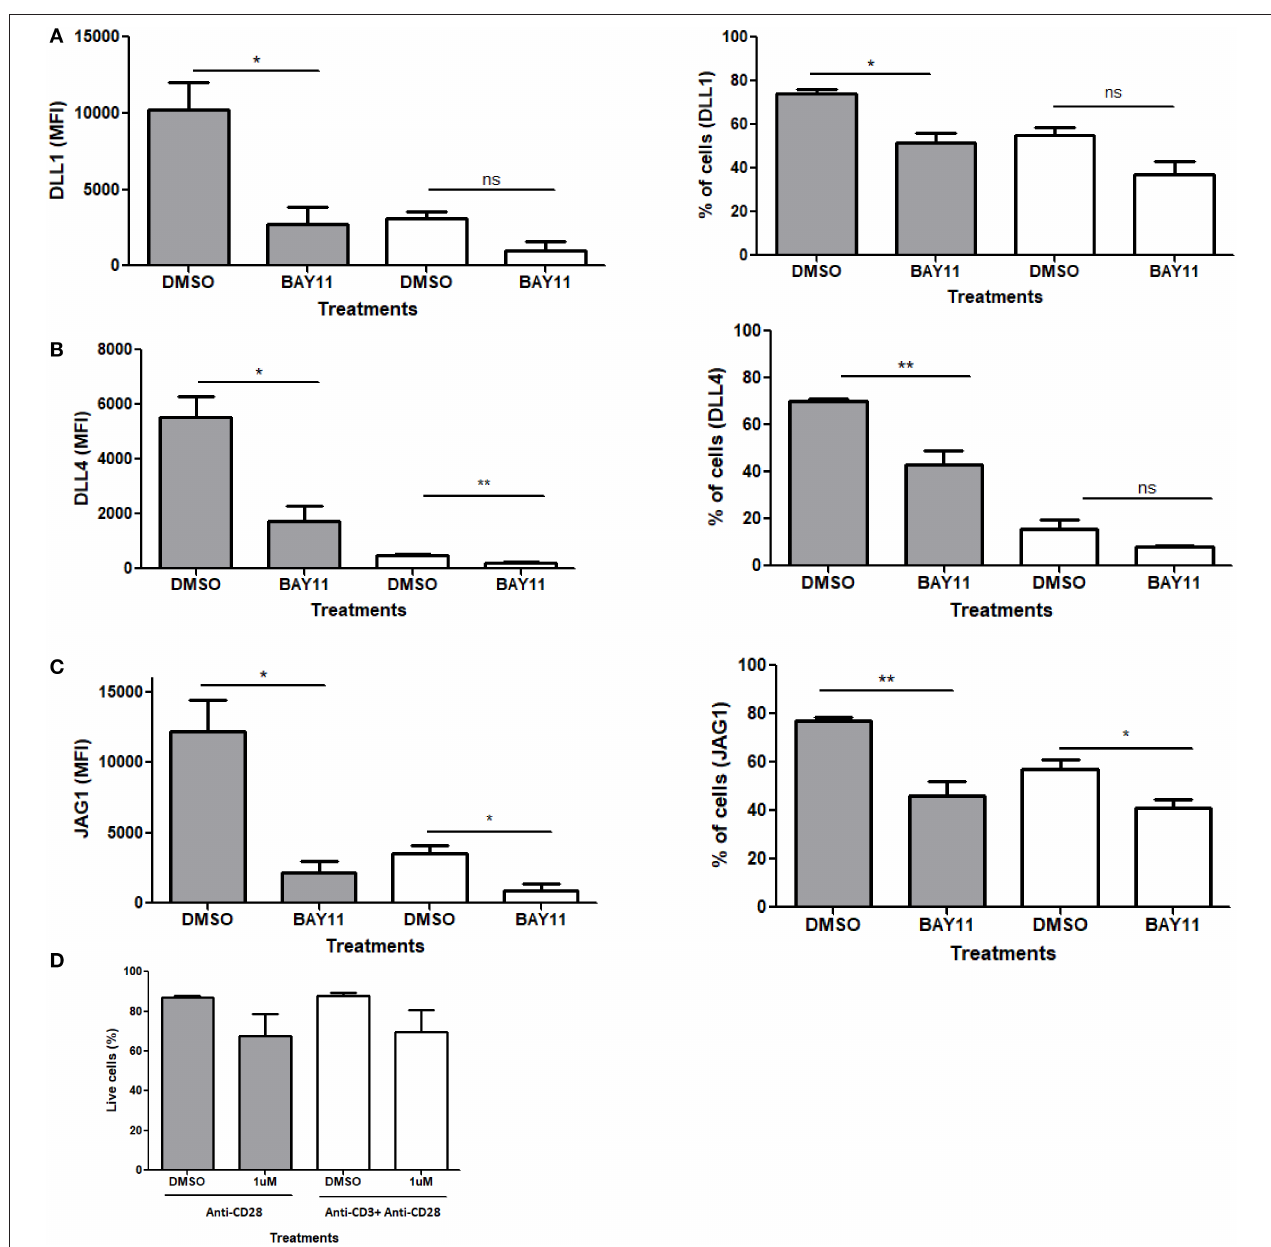
FIGURE 7 | NF κ B regulates Notch ligand expression downstream of CD28. CD4T cells from C57BL/6 mice were treated with soluble anti CD28 or anti-CD3 ε and anti-CD28 for 6h in the presence of NF κ B inhibitor BAy11 at 1 µ M or DMSO as control. Cells were harvested and analyzed by flow cytometry by gating on live cell population as determined by the absence of Zombie staining. MFI values and percentage of ligand positive cells were plotted for (A) DLL1, (B) DLL4, and (C) JAG1. (D) Viability of cells post-treatment. Cells were harvested and analyzed by flow cytometry by gating on live cell population as determined by the absence of Zombie staining. Data represents three independent experiments Data represents mean ± SEM. * p < 0.05, ** p < 0.005. ns, not